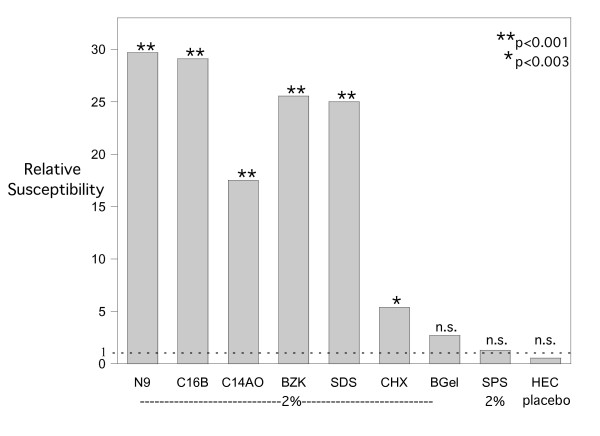
Vaginal HSV-2 susceptibility 12 hours after a single application of candidate microbicides. P values (from Table 1), determined by Fisher's exact two-sided test as described in the caption for Figure 1. n.s. = not significant.